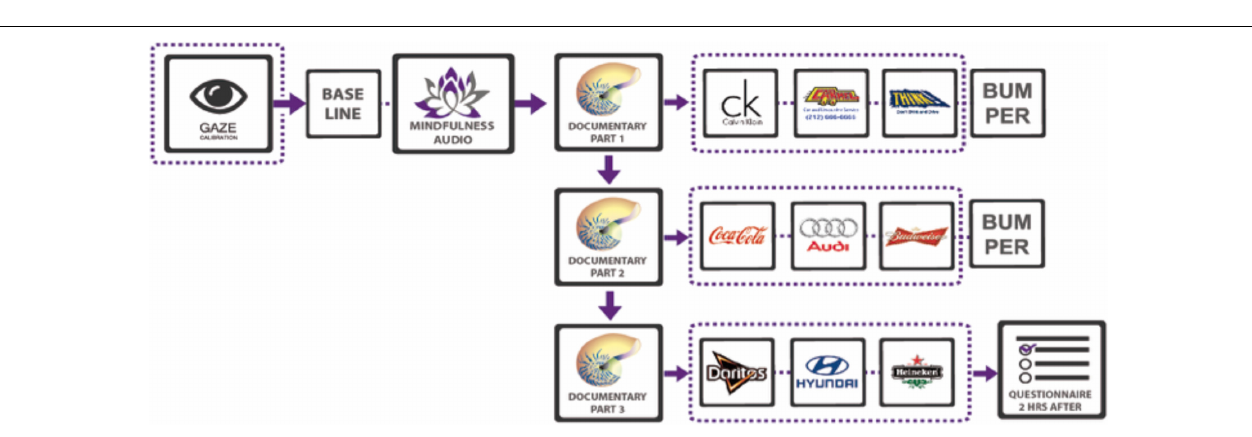
FIGURE 2 | Stimuli and experimental